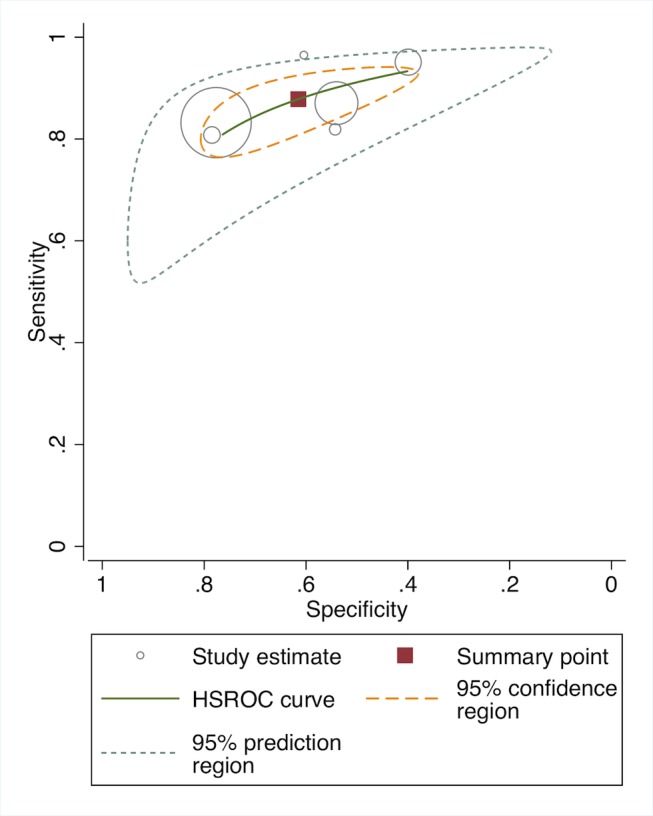
Receiver operating curve of studies of diagnostic accuracy of frontline health worker diagnosis of pBI compared to physician diagnosis.